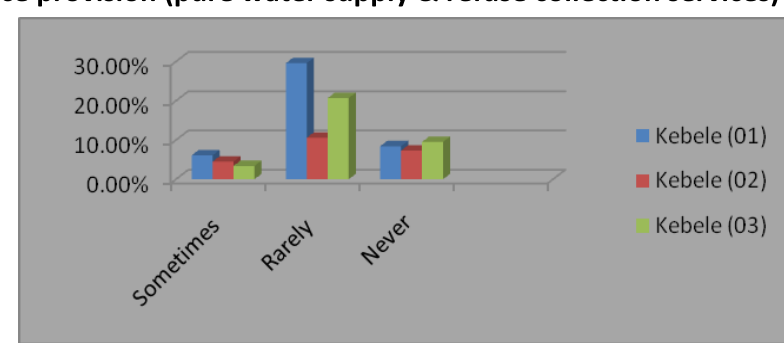
Figure 4: Access to pure water Source: Survey result,